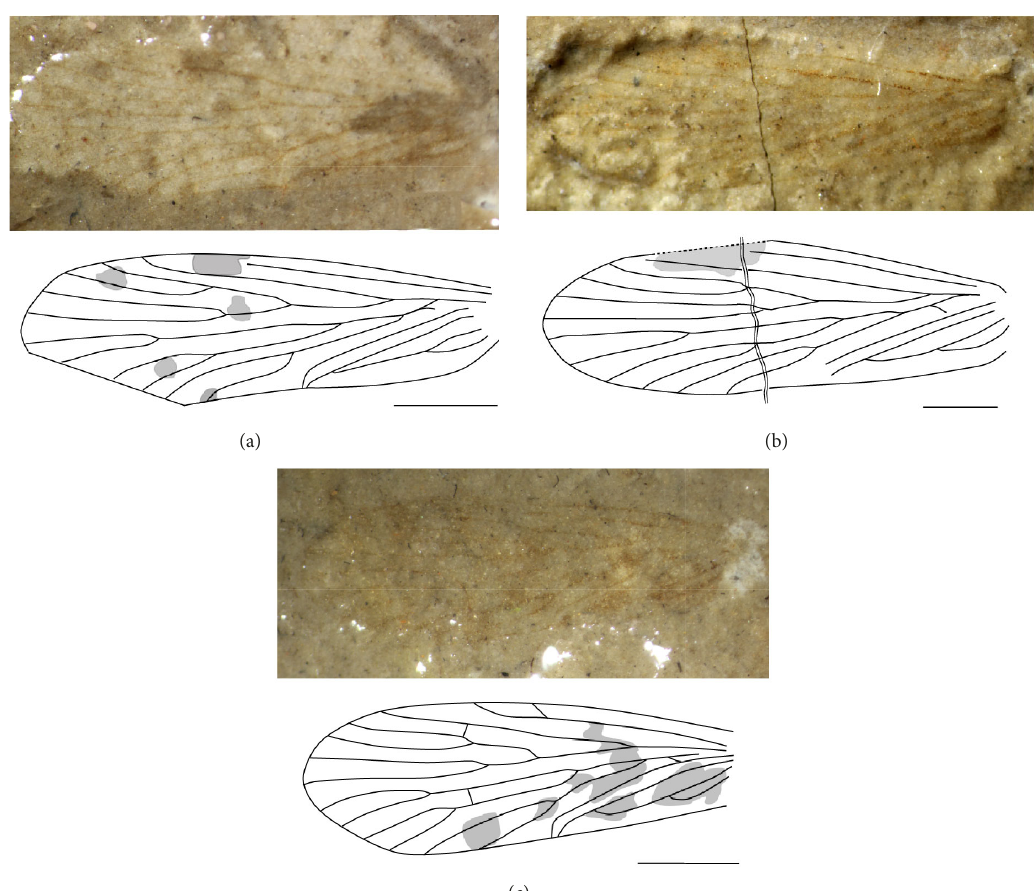
Figure 5: Previous holotypes now considered conspecific with Austaulius furcatus (Giebel, 1856). (a) “Necrotaulius apicalis” Tillyard, 1933 (NHMUKI.3081);(b) “N.stigmaticus” Tillyard,1933(NHMUKI.11584);(c) “N.westwoodi” Tillyard,1933(NHMUKI.11761),allfromWainlode Cliff, Gloucestershire. Scale bars = 1